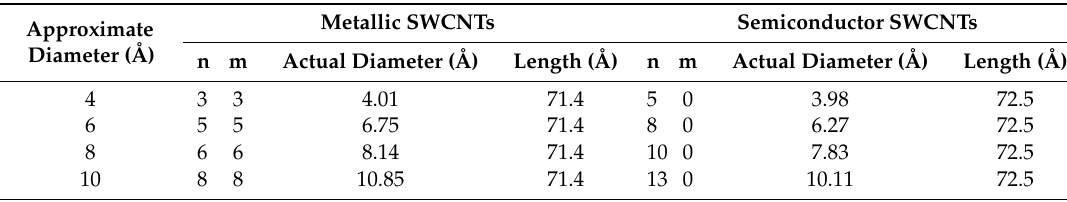
Table 1. Geometrical parameters of single-walled carbon nanotubes (SWCNTs).